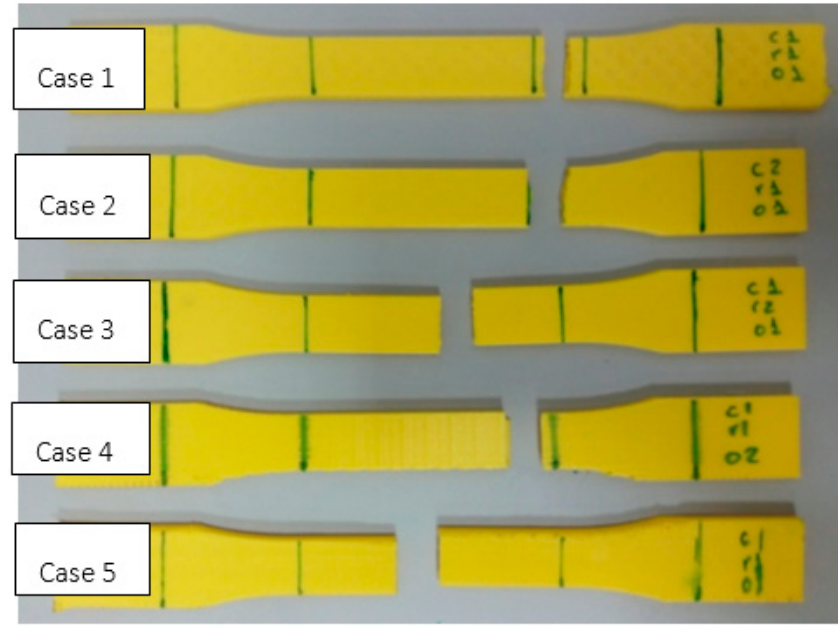
Figure 6. The PLA test specimens tested (one of each type).